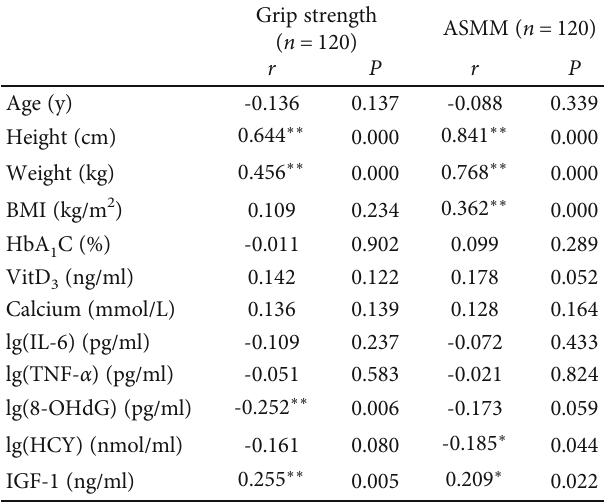
Table 2: Correlation analysis between skeletal muscle mass and strength with several